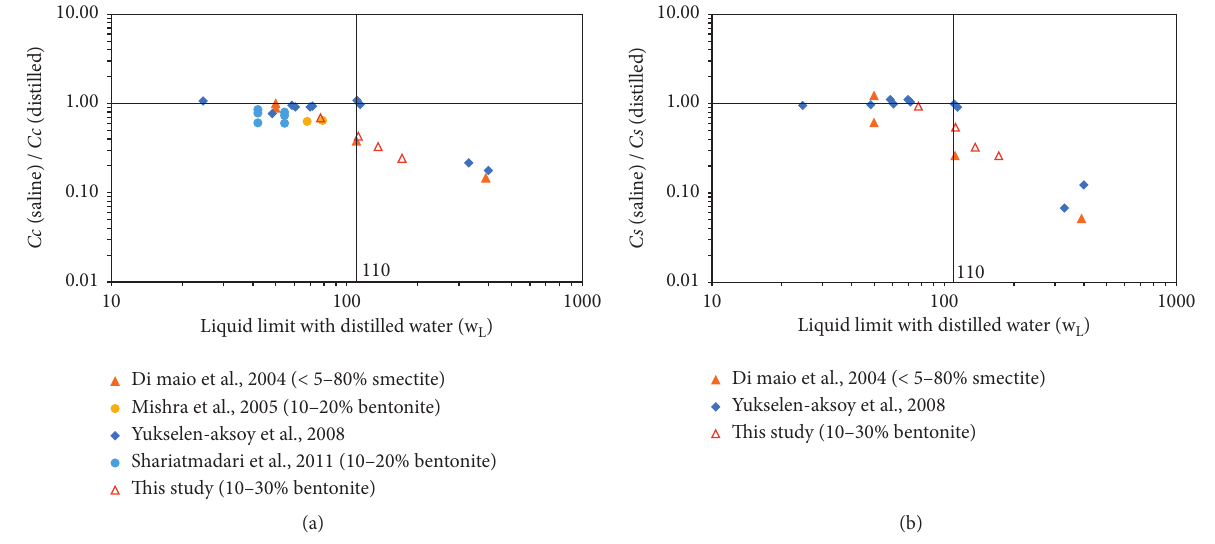
Figure 5: The relationship between the normalized swelling and compression indices concerning the pore fluid and liquid limit of clays in distilled